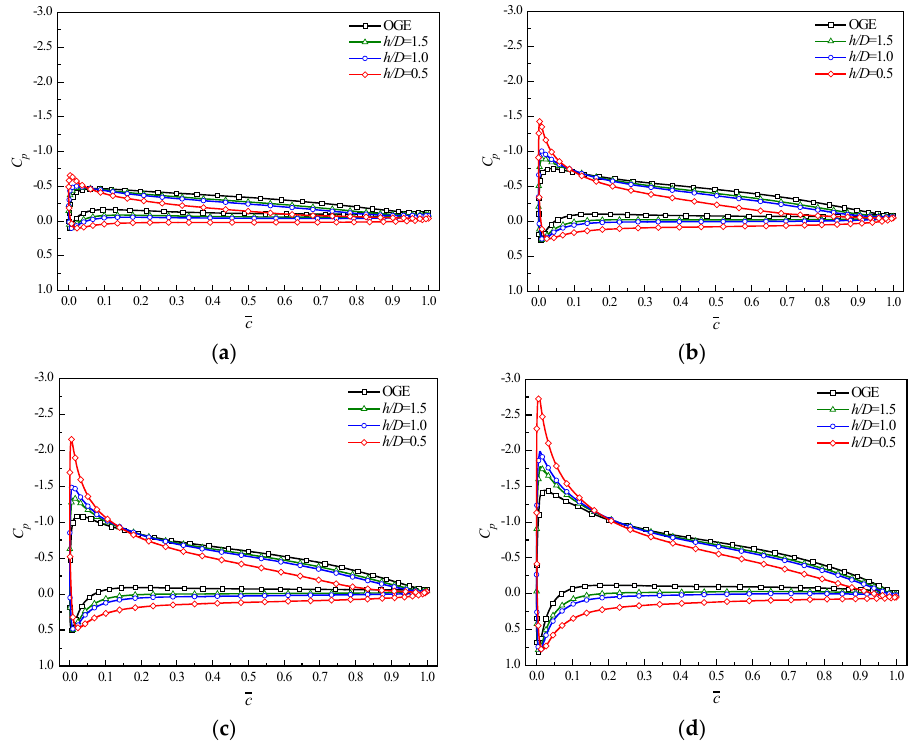
Figure 13. Chordwise pressure coefficient distribution at different radial locations: ( a ) r/R b = 0.35; ( b ) r/R b = 0.55; ( c ) r/R b = 0.75; ( d ) r/R b = 0.95.